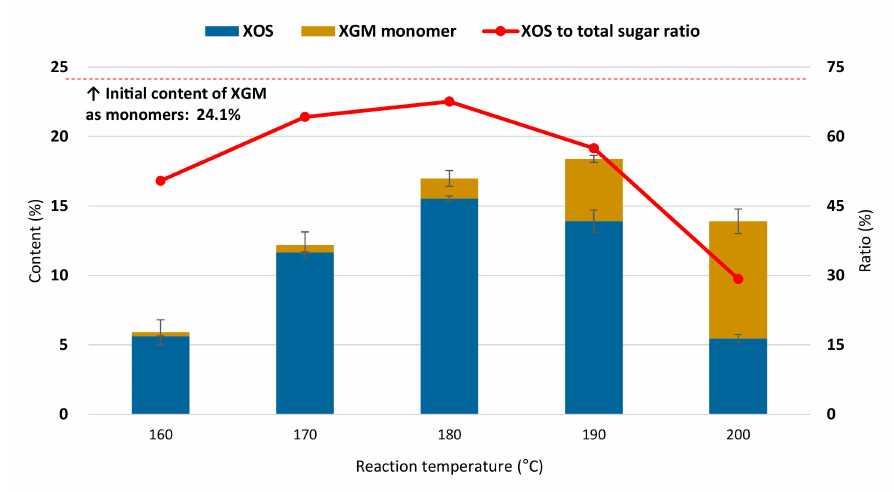
Figure 1. XGM content and XOS to total sugar ratio with the reaction temperature change.